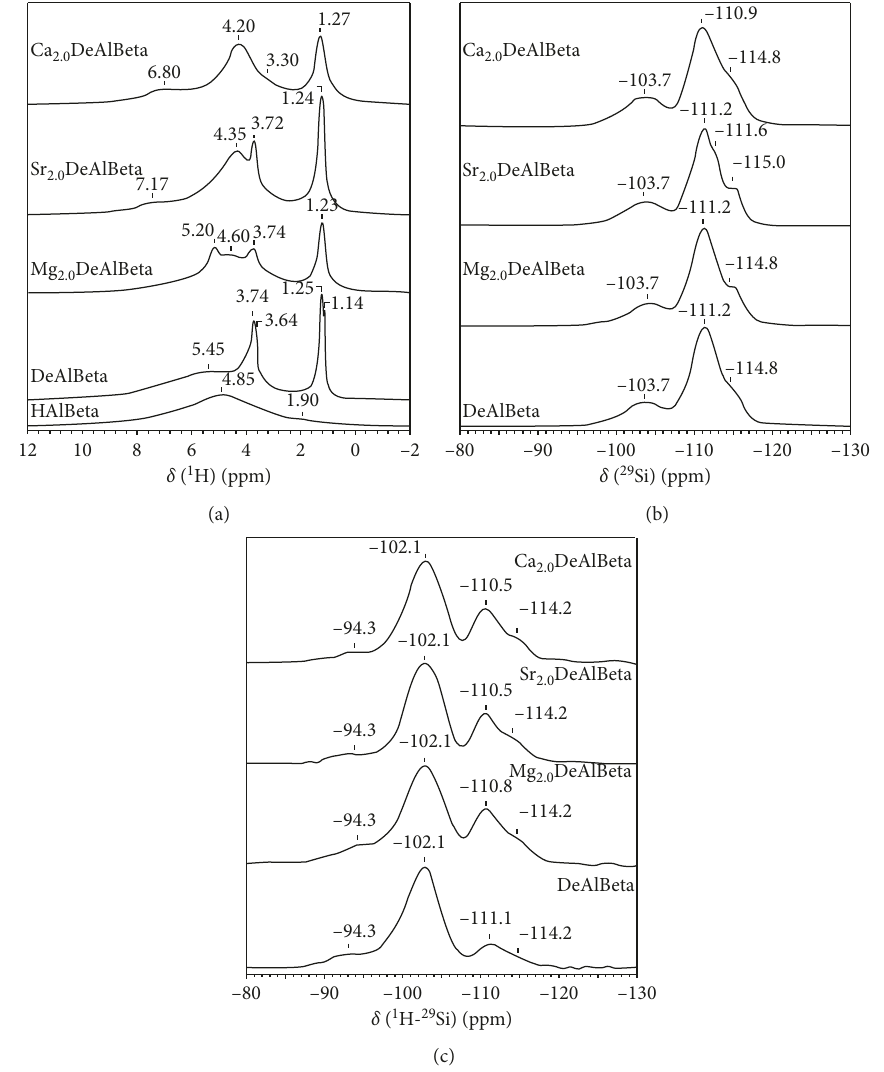
Figure 10: 1 H MAS NMR (a), 29 Si MAS NMR (b), and 1 H- 29 Si CP MAS NMR (c) spectra recorded at room temperature in 4mm